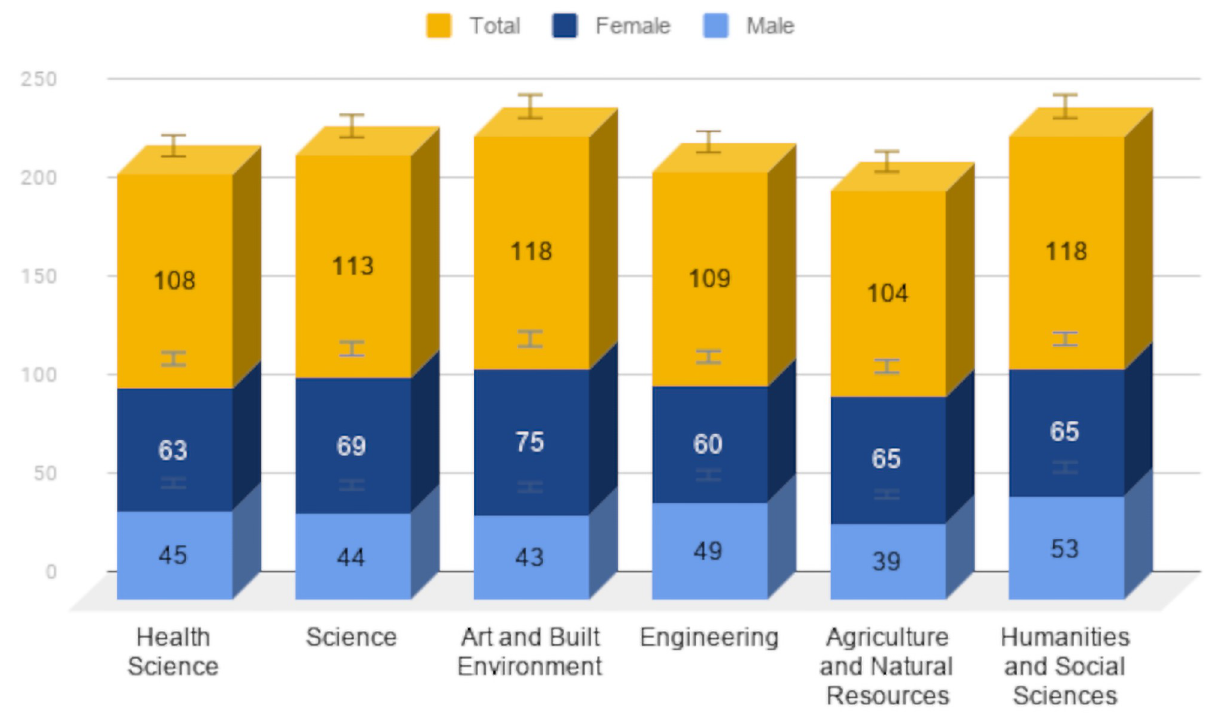
Fig 1. Gender distribution in the six colleges.